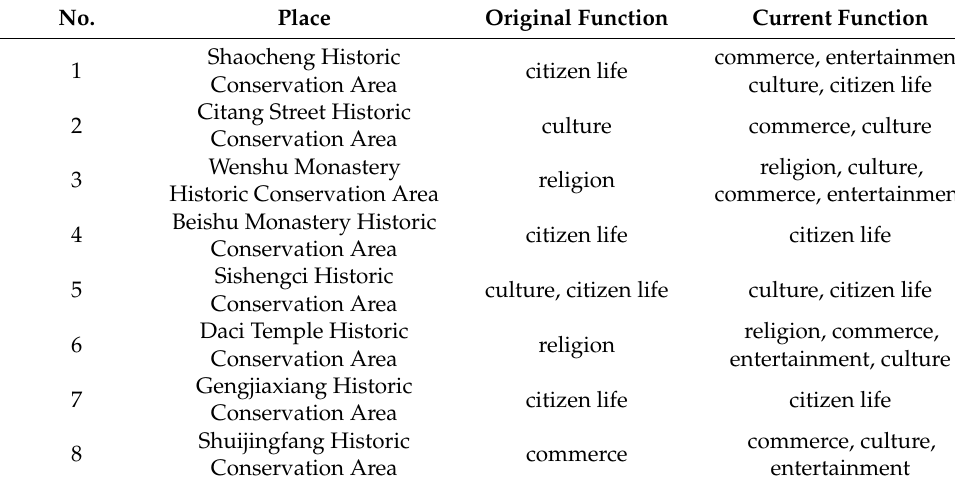
Table 3. Functional changes in the tourism